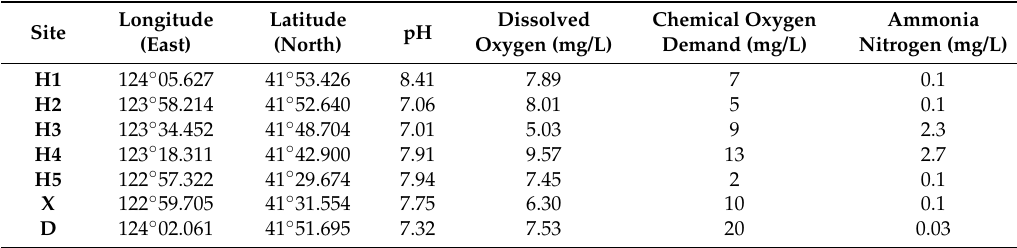
Table 1. Sampling location and physicochemical water parameters.